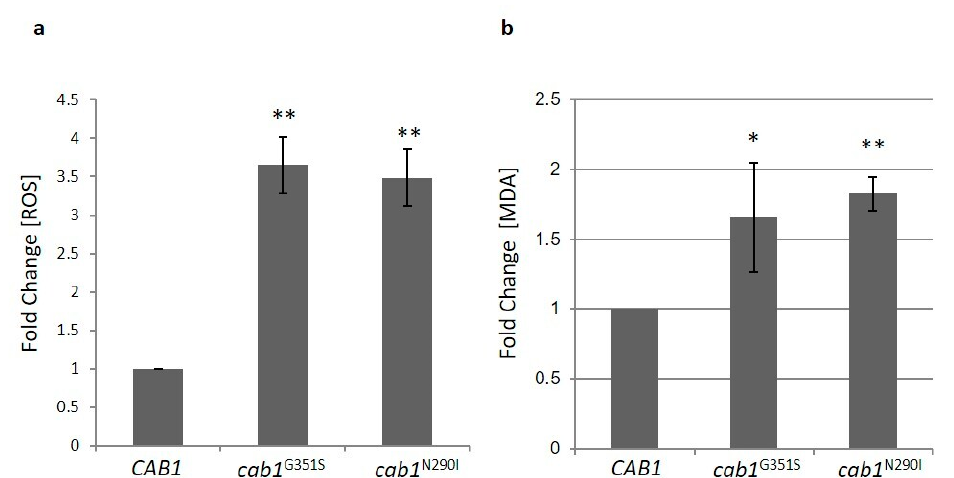
Figure 4. ( a ) ROS content evaluation by dichlorofluorescein diacetate assay in wild-type and mutant strains grown to the early stationary phase in SC medium containing 2% galactose. ( b ) Lipid peroxidation was evaluated by measuring malondialdehyde content in whole-cell extracts. The contents of ROS and MDA in cab1 mutants were normalized to the strain transformed with the CAB1 wild-type allele and the values are reported as fold change with respect to the wild-type. Values are means ± standard deviation. N = 4; n = 12 for each strain. *: p < 0.05; **: p < 0.01.